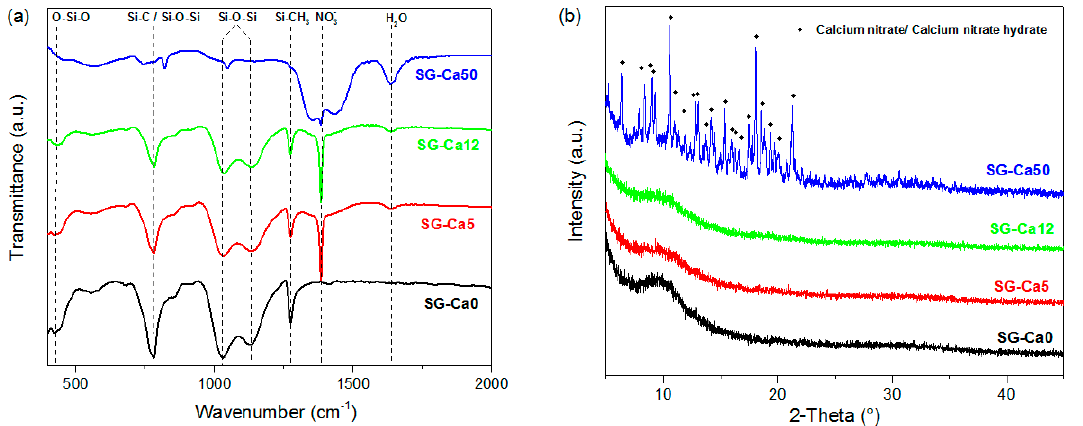
Figure 2. ( a ) FTIR spectra and ( b ) XRD diffractograms of xerogels SG-Ca0, SG-Ca5, SG-Ca12, and SG-Ca50.